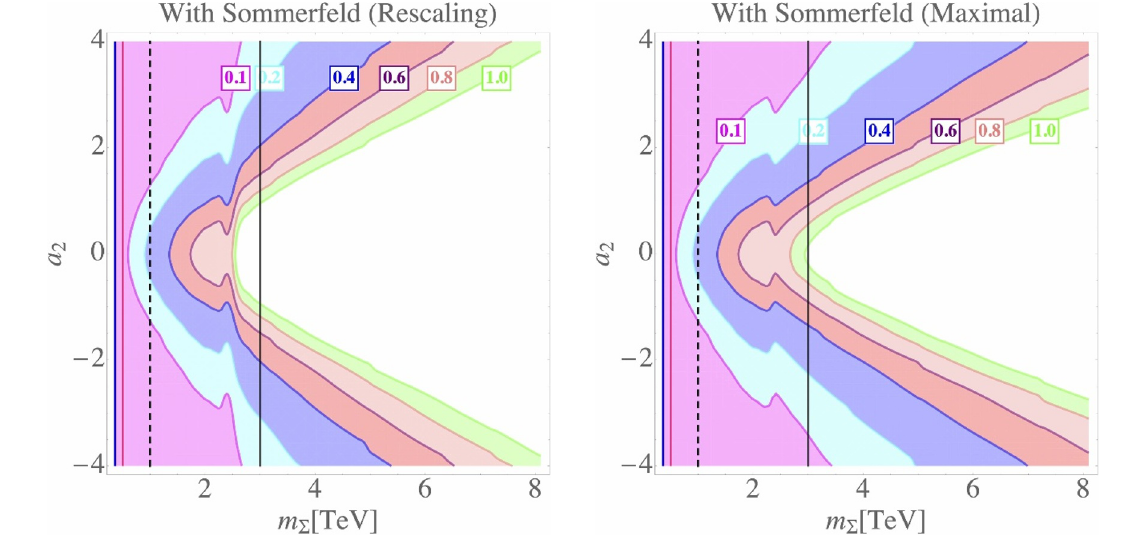
Figure 7 . Left panel: the right plot of figure 6, where the rescaling procedure is adopted for the Sommerfeld enhancement factor S to obtain the DM relic density. Right Panel: to estimate the uncertainty from the rescaling, we assume S stays at S max when interpolation of the S factor is not available. See the main text for a detailed